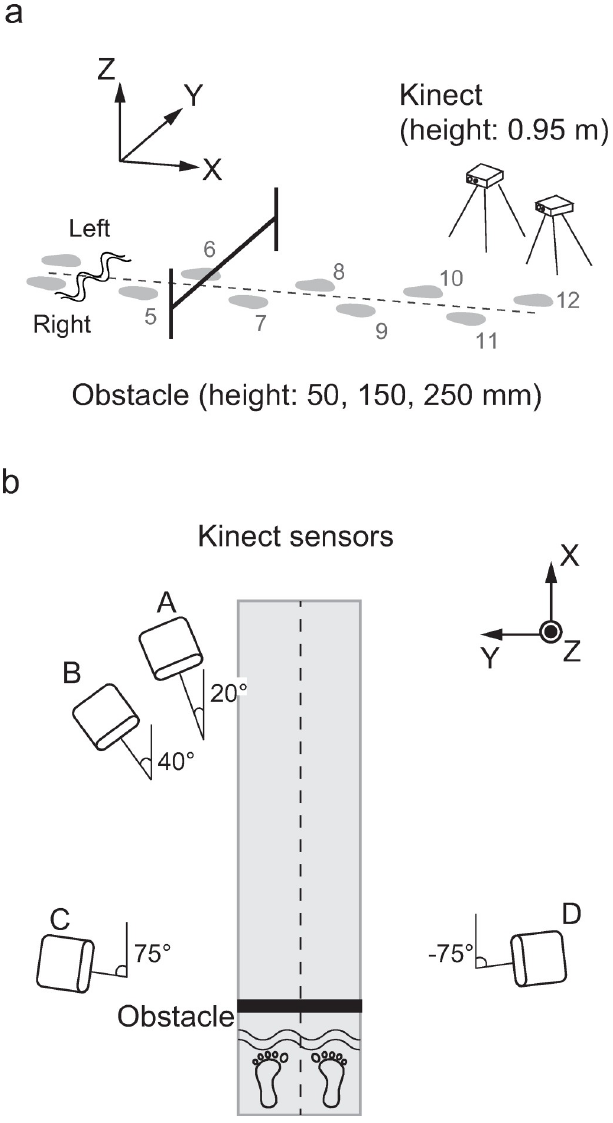
Fig 1. Experimental diagram. Participants crossedan obstacle(height: 50, 150, 250mm) at the 7th step,with their right limb being thelead limb(a). The Kinectsensors wereset up in two differentlayouts (b). In one layout,the sensor positions (locationA and locationB) werelocatedat a 20˚ angle and 40˚ anglerelative to the walkway on the trail limb side; in the otherlayout, the sensorpositions (location C and location D) were locatedon oppositesides, at a 75˚ angle and a -75˚ angle.